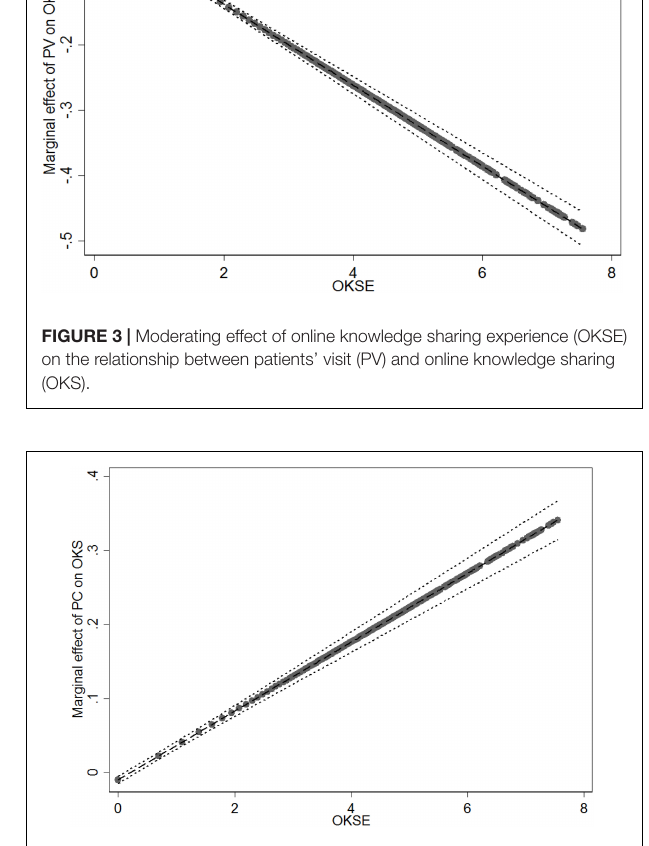
FIGURE 4 | Moderating effect of online knowledge sharing experience (OKSE) on the relationship between patients’ consultation (PC) and online knowledge sharing